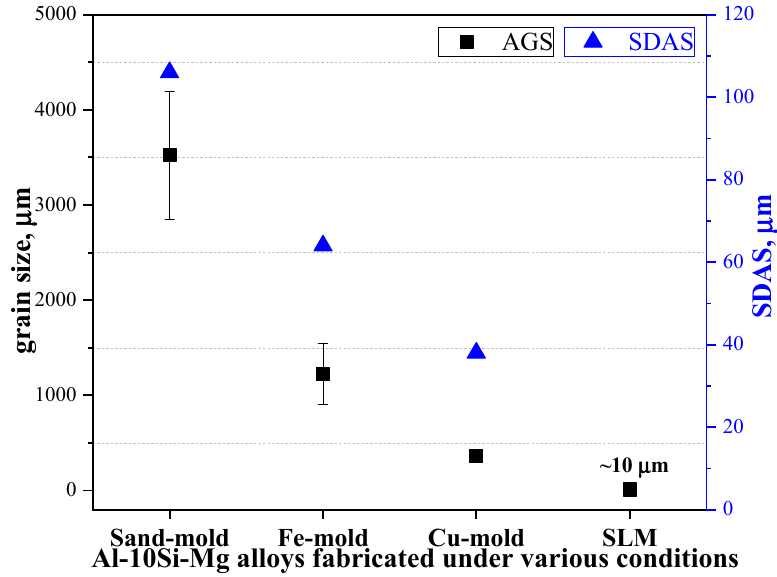
Figure 6. Average grain size of Al-10Si-0.5Mg alloys prepared under different conditions. No SDAS data for SLM alloy due to inapparent dendrites.